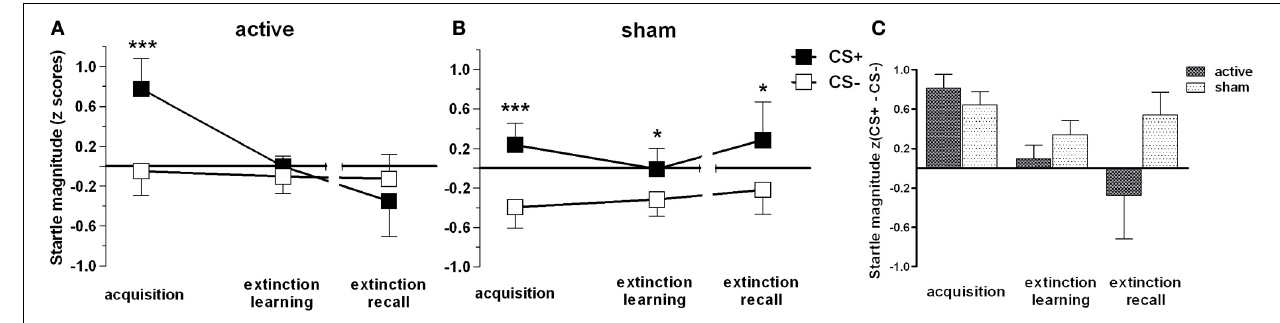
FIGURE 2 | Fear-potentiated startle magnitudes for CS + and CS − trials for active (A) and placebo (B) group and the difference score (C) accordingly. In all experimental phases mean responses and standard errors of the mean (SEM) are depicted. Asterisks indicate significant